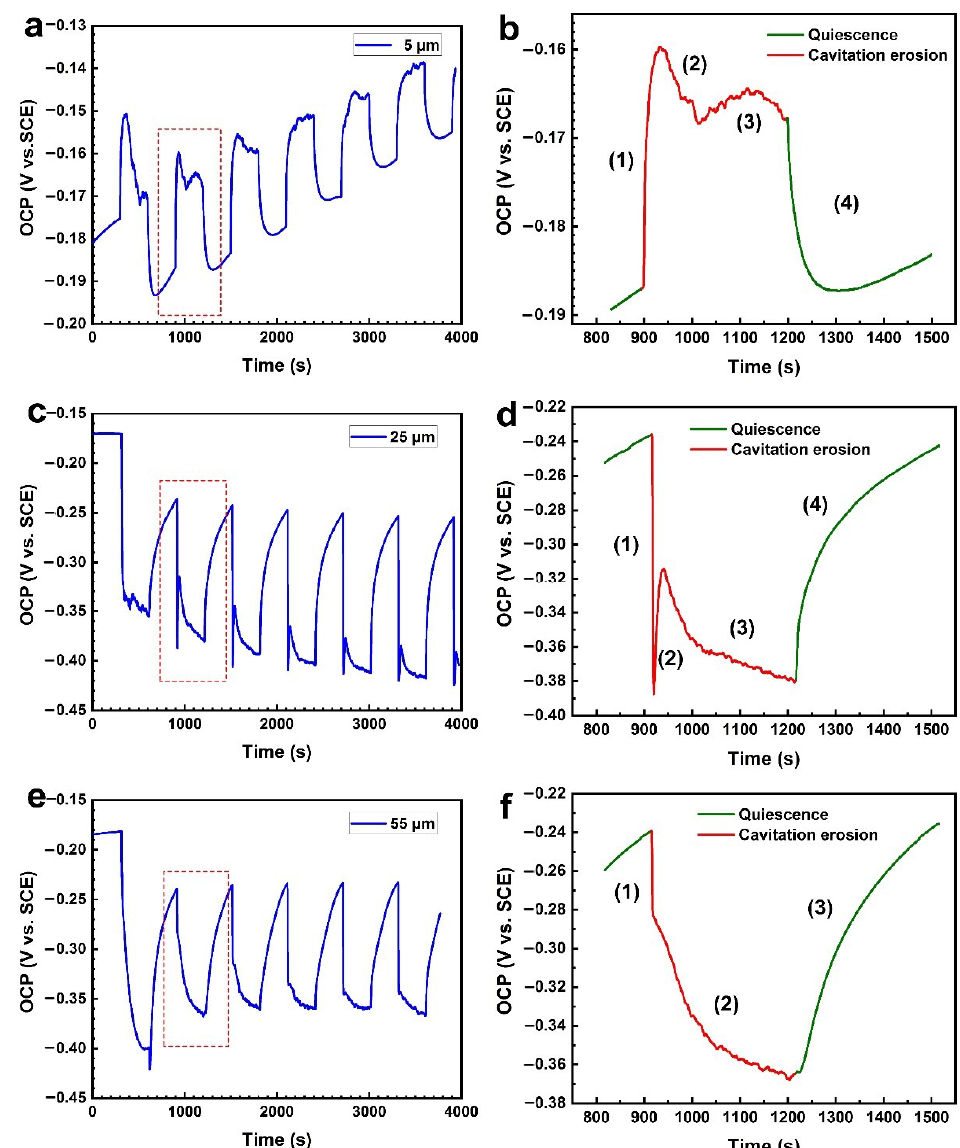
Figure 4. OCP of 316L SS under alternating CE and quiescence states of 300 s dwelling times with different CE amplitudes of ( a , b ) 5 μ m, ( c , d ) 25 μ m and ( e , f ) 55 μ m. With a CE amplitude of 5 μ m, Figure 4b shows that each CE–quiescence cycle in- cludes four stages. In stage 1, OCP changes from − 186.6 mV to − 159.7 mV, proceeding